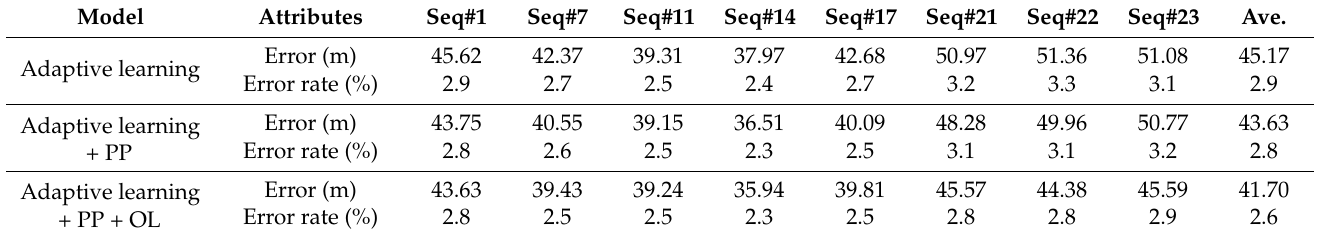
Table 6. Performance comparison of walking distance with different models, including Adaptive learning, Adaptive learning with Preprocessing (Adaptive learning + PP), and Adaptive learning with Preprocessing and Online Learning (Adaptive learning + PP +